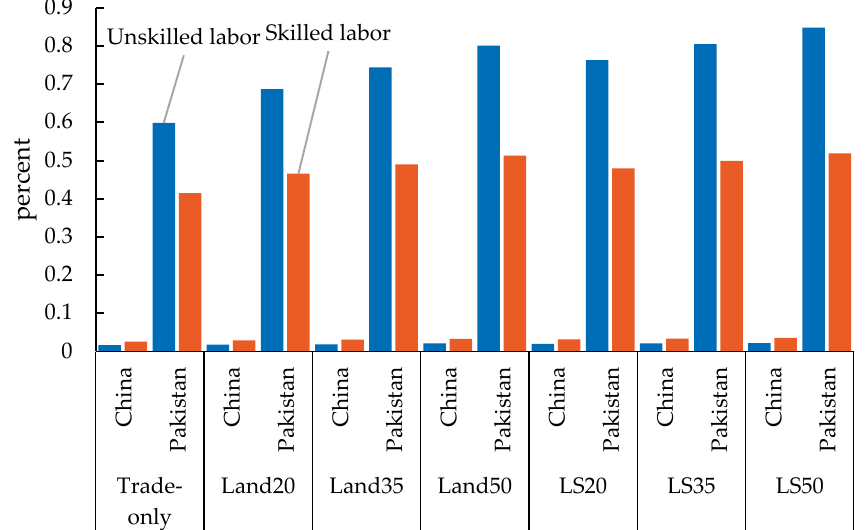
Figure 2. Changes in wages in both countries by labor type compared to baseline. Source: Simulation results.